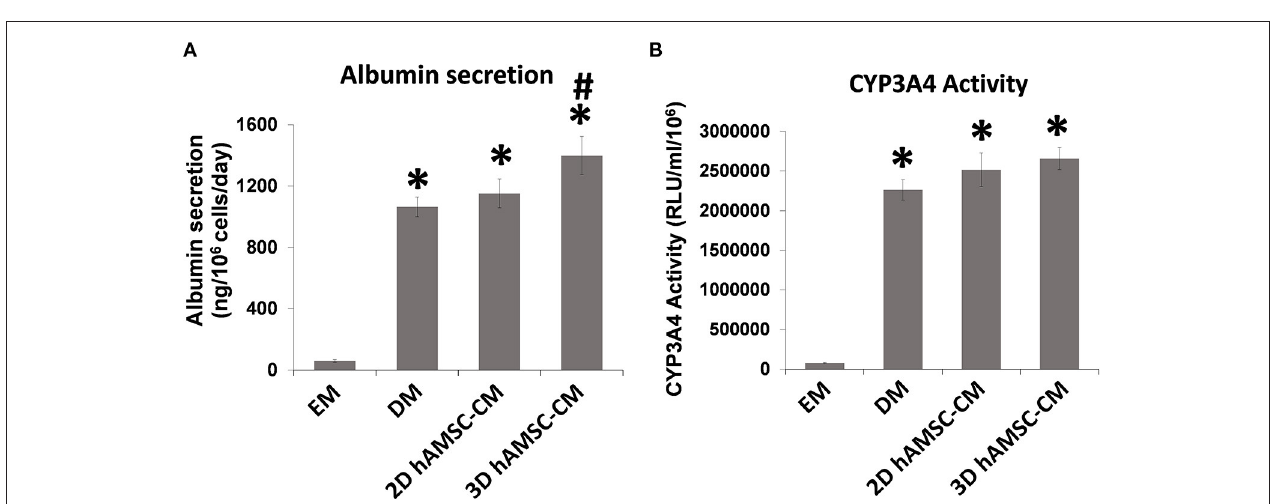
FIGURE 4 | Analysis of (A) albumin secretion and (B) CYP3A4 activity in human liver organoids differentiated for 15 days in each condition. EM, expansion medium; DM, differentiation medium; 2D hAMSC-CM, DM conditioned for 3 days by hAMSCs grown in monolayer, 3D hAMSC-CM, DM conditioned for 3 days by hAMSCs grown as spheroids. Data are means ± SD. * p < 0.05 vs. EM. # p < 0.05 vs. 2D